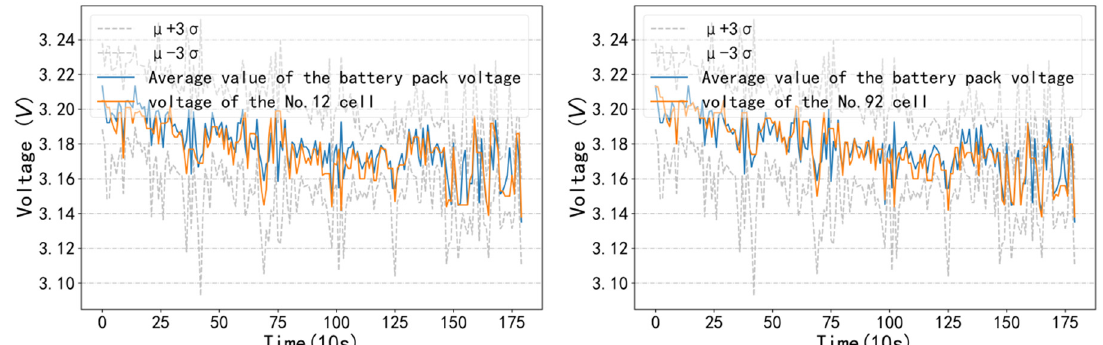
Figure 5. Box plot of ICC s of different vehicles. Box plots can not only observe the distribution of data but can also be used to re- move outliers. Up to more than 90 percent of the data is contained between the upper and lower limits in the box plot, so the lower limit can be used as a threshold to remove abnormal data. Since the amount of data in the sub-health state is only a small part of the overall data volume, the lower limit can also be used as the identification criterion for the sub-health state. Although the lower limit values under different working condi- tions are above 0.7, the specific values are different, and for the reliability of the thresh-